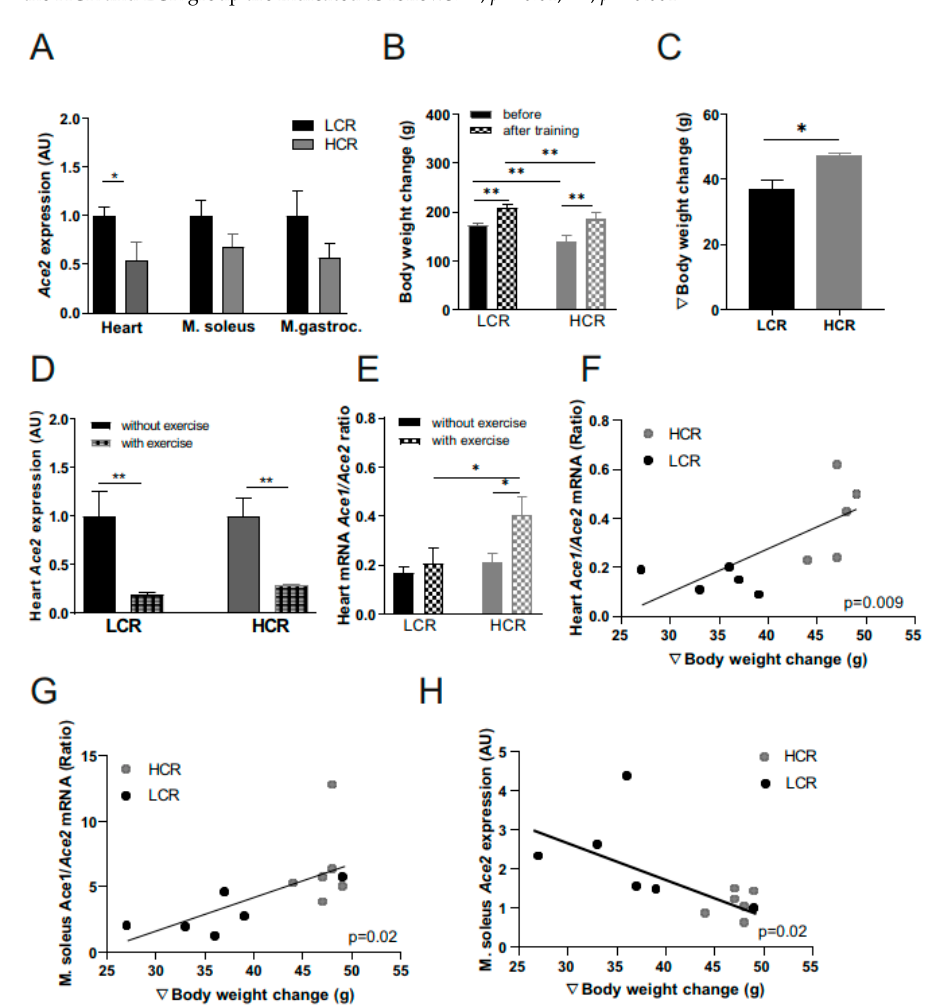
Figure 4. ACE2 and ACE1/ACE2 ratio mRNA expression in skeletal muscle and heart of low- versus high-capacity rats and in response to 4 weeks of interval training. The effects of a previously reported high-intensity aerobic interval training [15] was investigated in 19-week-old female high-capacity runners (HCRs, n = 5) and compared to low-capacity runners (LCRs, n = 5). ( A ) Baseline ACE2 mRNA expression differences in heart and different skeletal muscles (Musculus soleus, M. soleus; Musculus gastrocnemius, M. gastroc.) between LCR and HCR rats. ( B ) Effects of a 4 weeks of intensive aerobic interval training on: body weight summarized as body weight change; ( C ) and the heart ACE2 mRNA expression in LCRs and HCRs ( D ). Effects of 4 weeks of intensive aerobic interval training on the ACE2/ACE1 mRNA ratio in the heart ( E ) as well as the correlation of heart ( F ) and M. soleus ( G ) ACE1/ACE2 ratio to body weight change. Correlation analysis of ACE2 ex- pression in M. soleus and body weight change ( H ). mRNA level was normalized to 18sRNA. Results are expressed as the means ± SE. *, p < 0.05; **, p < 0.01. Differences among the groups were per- formed using t-test or linear regression analysis with GraphPad Prism 9 Software (Jandel Scientific, San Rafael, CA, USA). 3. Discussion We showed in this analysis, for the first time, that a lower ACE2 expression in tissue, higher ACE levels in serum, and metabolome differences are related to high intrinsic aer- obic exercise capacity. Exercise training reduces ACE2 expression in heart and muscle and the strength of this effect depends on the strength of the response to exercise. These results lend support to the suggestion of greater SARS-CoV-2 resistance in physically fit and ac- tive individuals. In the ongoing COVID-19 pandemic, it is surprising how little is known about the role of exercise in the susceptibility for infection and whether regular physical activity